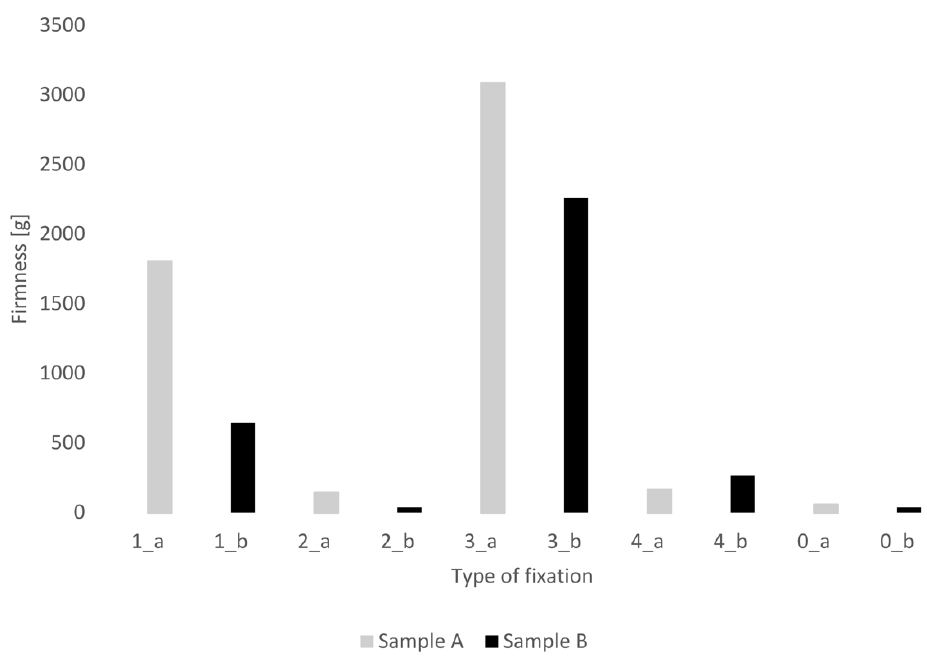
Figure 2. Comparison of texture measurement (firmness) results for processed cheese samples [g]. Effect of fixation to the firmness of processed cheese samples. Notes: 0—no fixation, 1—AFA, 2—10% formol, 3—100% ethanol, 4—Carnoy’s